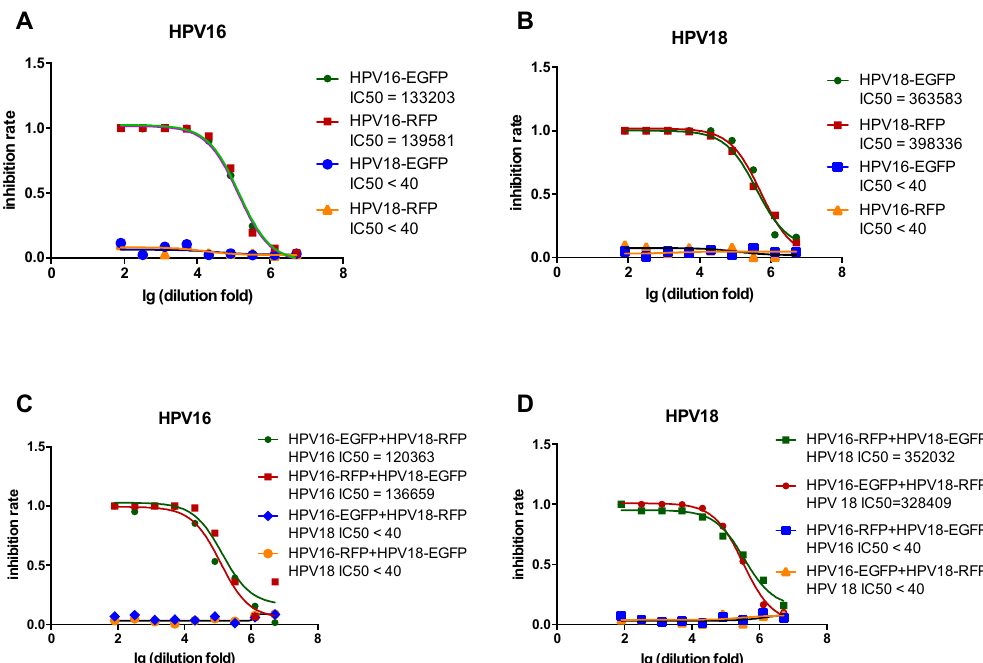
Figure 4. Comparison of single- and dual-color PBNA in detecting inhibition rates. ( A ) Single-color HPV16 and HPV18 pseudovirions were tested against mono-valent HPV16 vaccine immunized rabbit serum; ( B ) Single-color HPV16 and HPV18 pseudovirions were tested against monovalent HPV18 vaccine immunized rabbit serum; ( C ) Dual-color HPV16 and HPV18 pseudovirions mixtures were tested against monovalent HPV16 vaccine immunized rabbit serum; ( D ) Dual-color HPV16 and HPV18 pseudovirion mixtures were tested against monovalent HPV18 vaccine immunized rabbit serum.